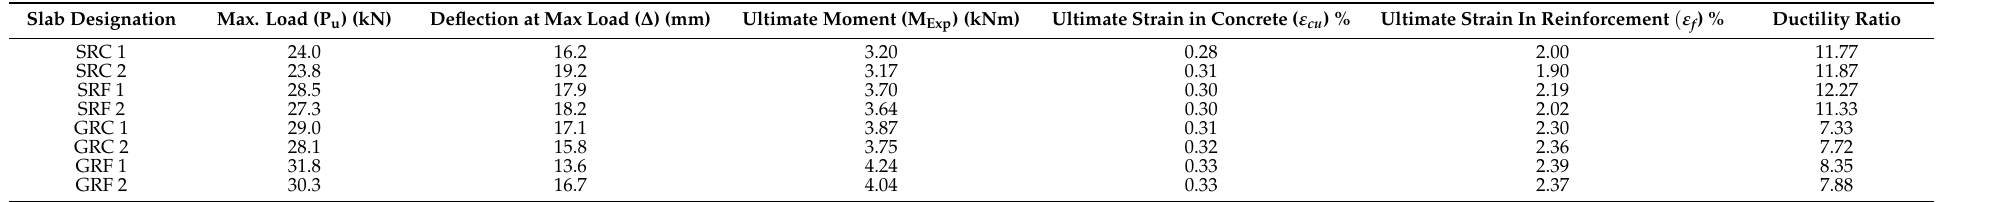
Table 6. Performance details of the slabs reinforced with steel rods and GFRP